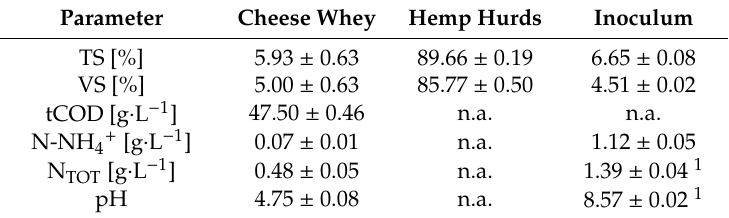
total solids; VS: volatile solids: tCOD: total chemical oxygen demand; N-NH 4 + : ammonium nitrogen; N TOT : total nitrogen. All the values are expressed as mean and standard deviation obtained using three